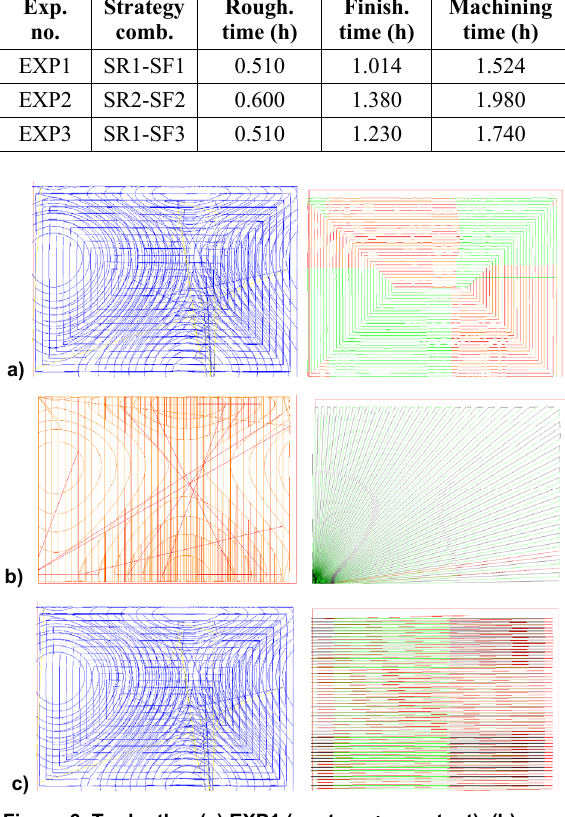
Figure 6. Toolpaths: (a) EXP1 (contour + constant), (b) EXP2 (hatch + spiral), and EXP3 (contour + linear) [12]